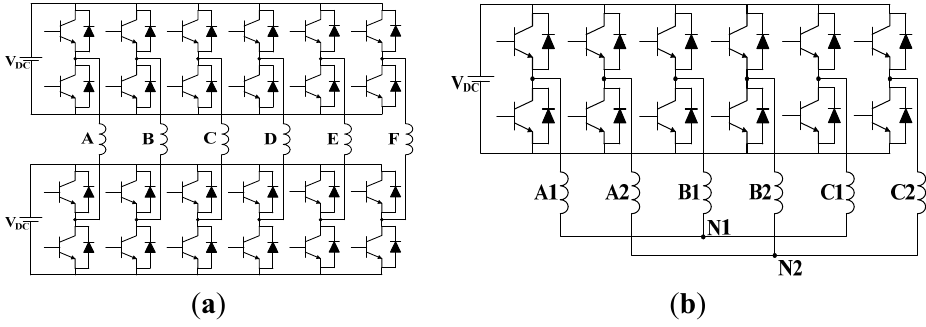
Figure 1. Configurations of inverter for open winding PMSMs and Y-connected winding: ( a ) Full-bridge-inverters-fed open winding; ( b ) Half-bridge-inverters-fed Y-connected winding.